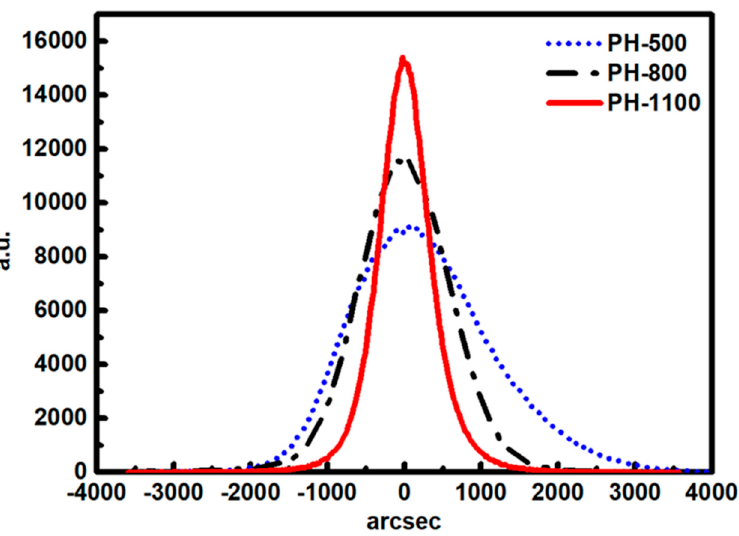
Figure 4. Symmetric X − ray rocking curves (XRCs) of the 1- µ m (0 0 2) GaN film on different preheated substrates. FWHMs of XRC curves are 2025 arcsec (PH-500), 1365 arcsec (PH-800), and 779 arcsec (PH-1100).